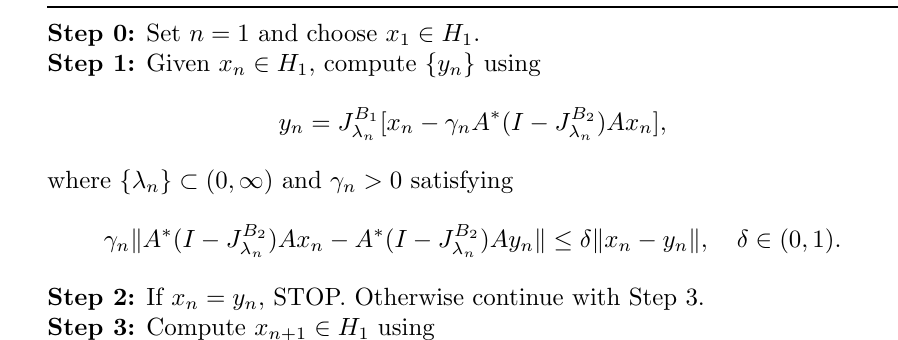
Algorithm 1. Descent Projection Algorithm